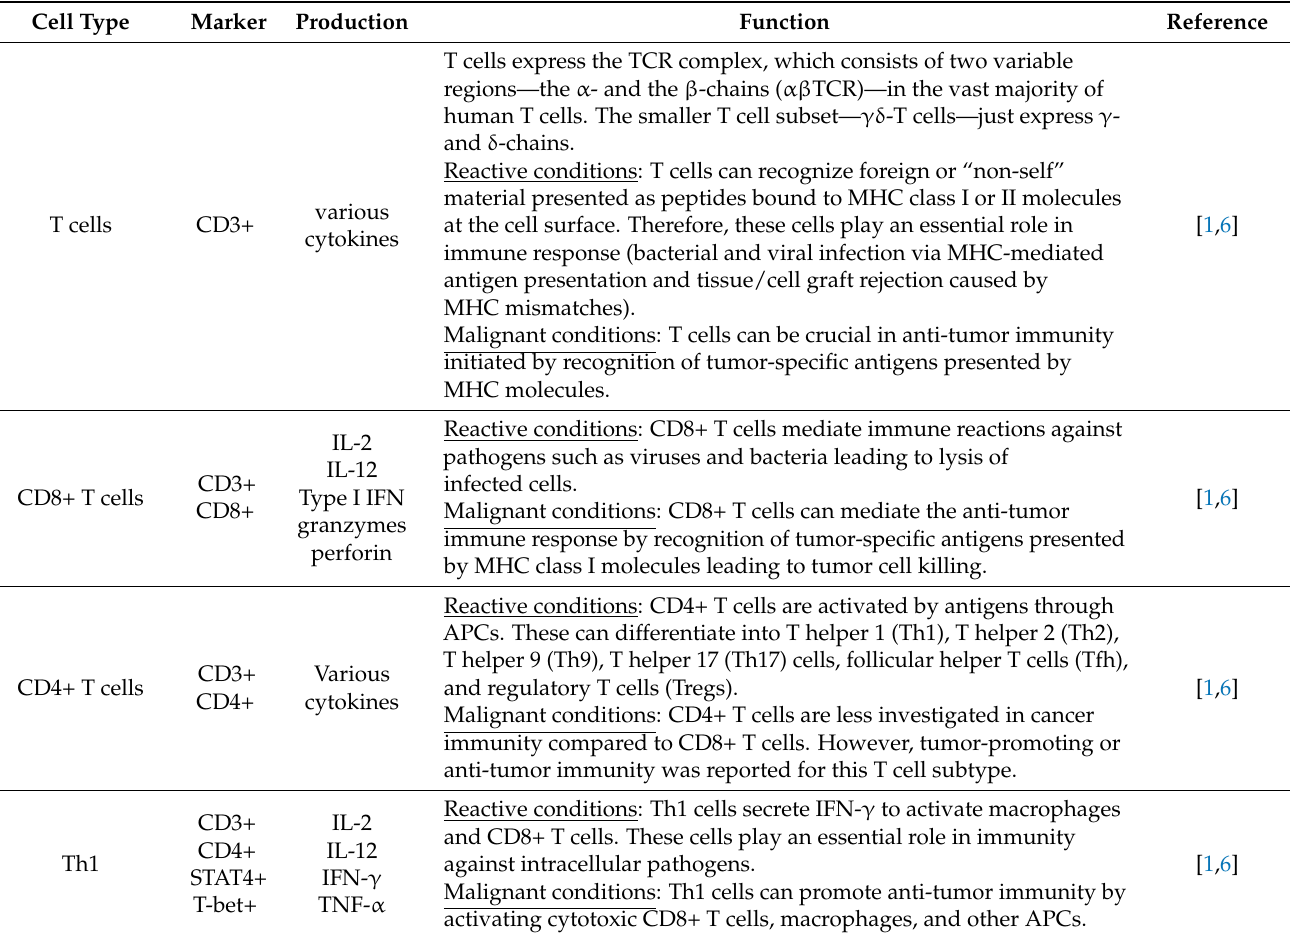
Table 2. Cells of the adaptive immune system in TME: T cell